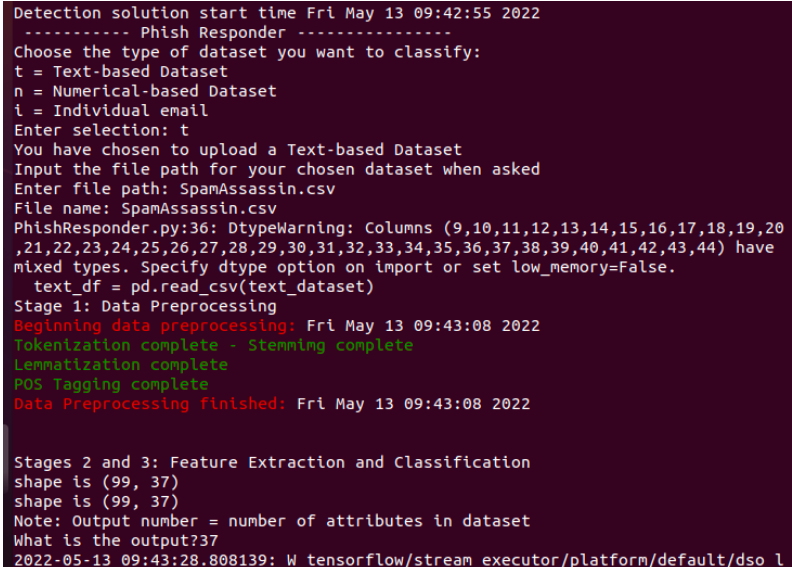
Figure 8. Command line.